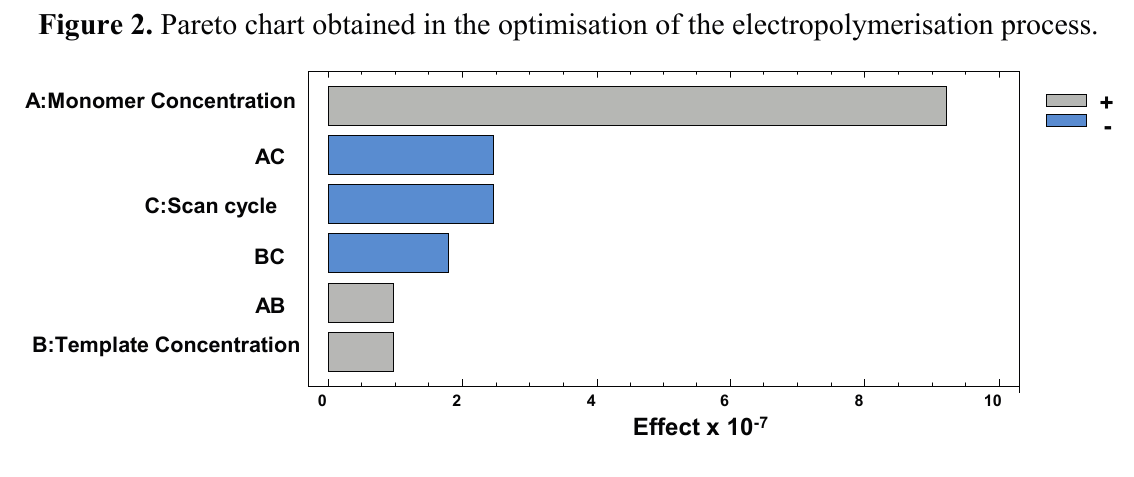
Figure 3. Main effects plot showing the effect of low and high values for the main variables on the intensity of the